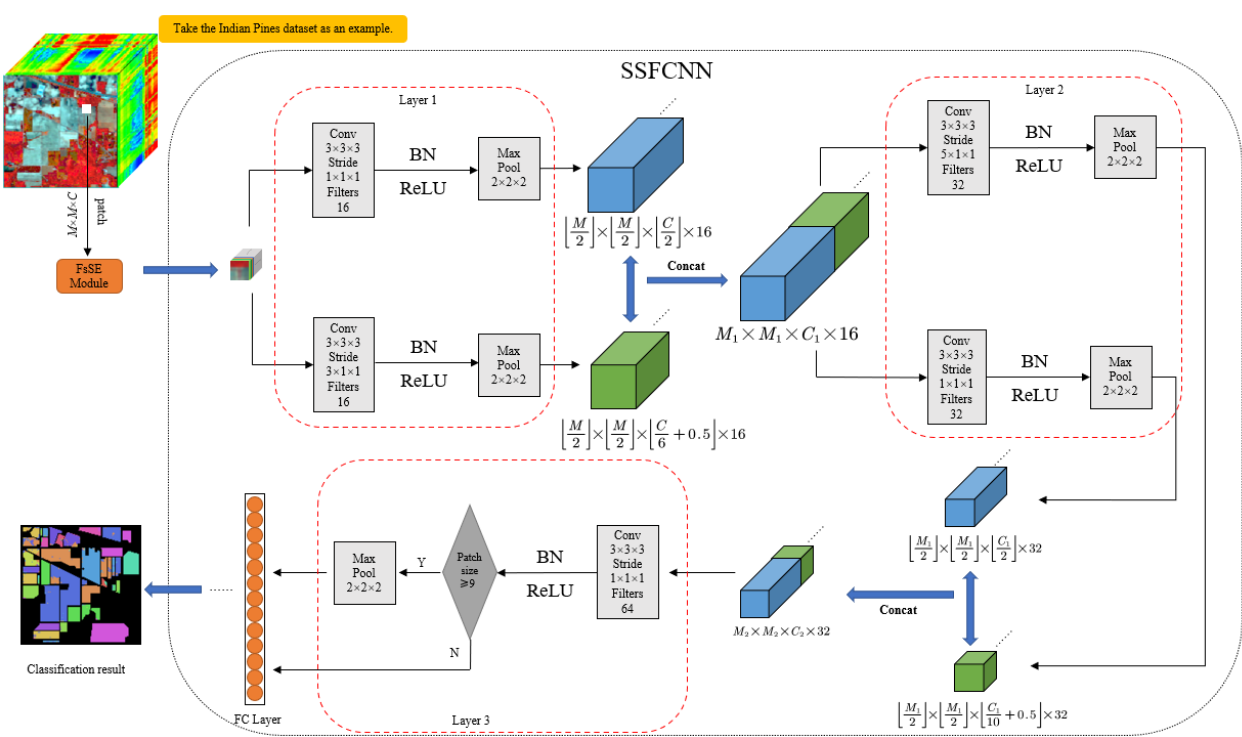
Figure 4. The structure of SSFCNN.